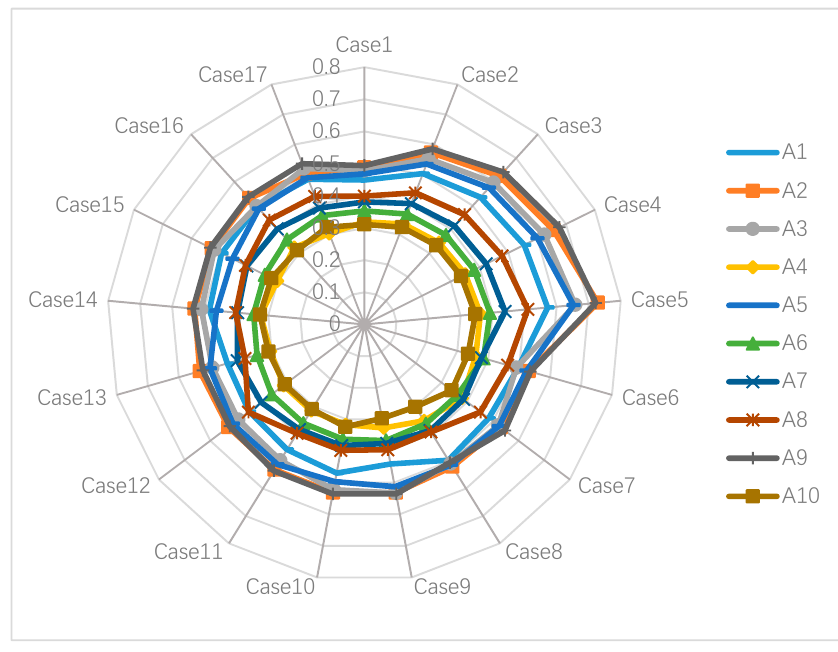
Figure 4. Results of sensitivity analysis.